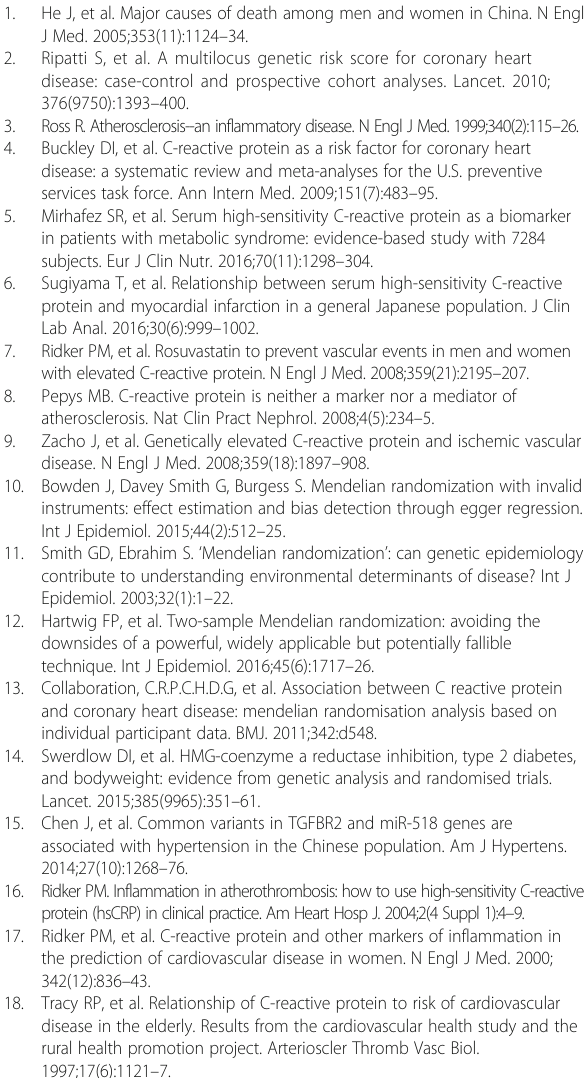
Abbreviations CHD: Coronary heart disease; CI: Confidence interval; CVDs: Cardiovascular diseases; DL-C: High-density lipoprotein cholesterol; GLU: Glucose; HR: Hazard ratio; HRG: High risk group; Hs-CRP: High-sensitivity C-reactive protein; IV: Instrumental variable; LDL-C: Low-density lipoprotein